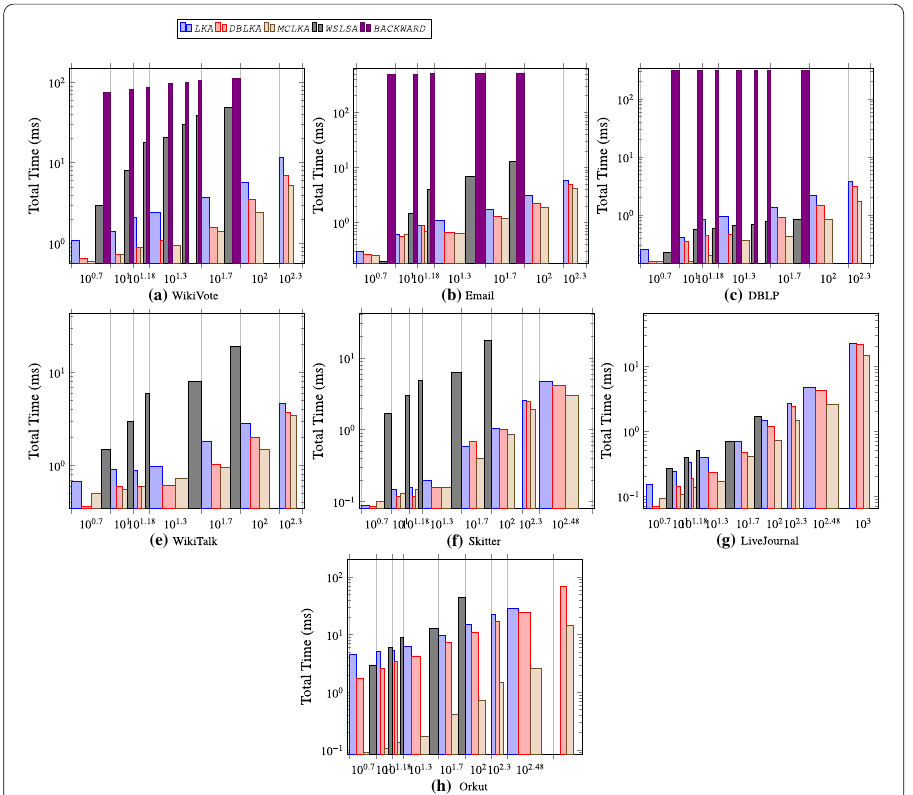
Fig. 9 Evaluation time of the proposed algorithms against Backward and WSLSA Algorithms while k and r is